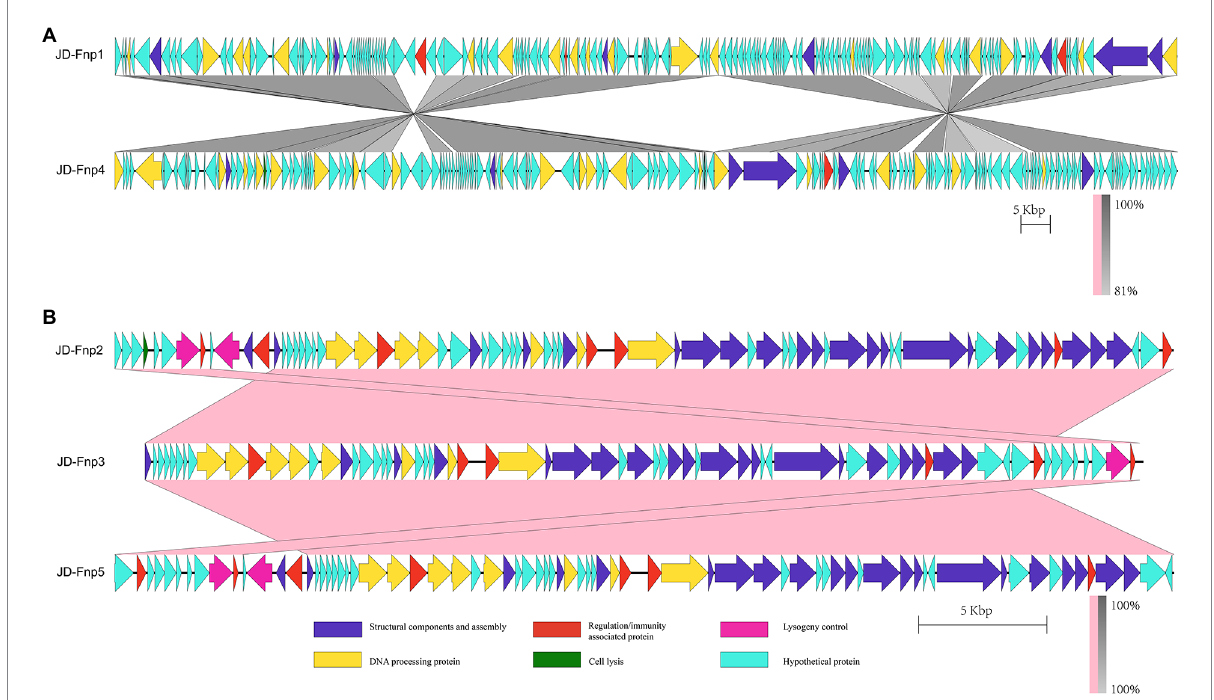
FIGURE 8 Comparative genomic analysis of JD-Fnp1 ~ JD-Fnp5. (A) JD-Fnp1 and JD-Fnp4; (B) JD-Fnp2, JD-Fnp3 and JD-Fnp5. Analysis was performed with blastn (BLAST v2.2.31+) at DNA level. The nucleotide identity of the homologous regions (percentage) is shown as a color gradient, the pink bar represents for forward blast hits and the gray bar represents for inverted blast hits; the scale is shown below. Known functional homologous genes are shown